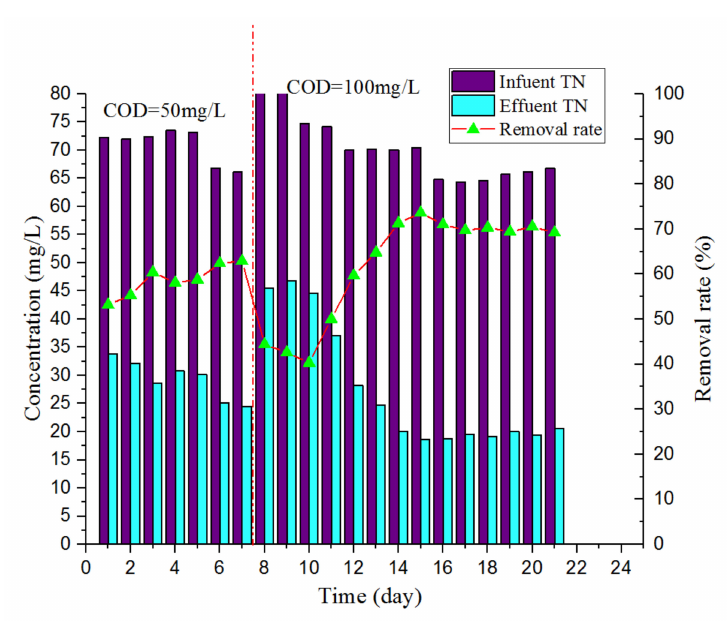
Figure 6. Changes in the content of